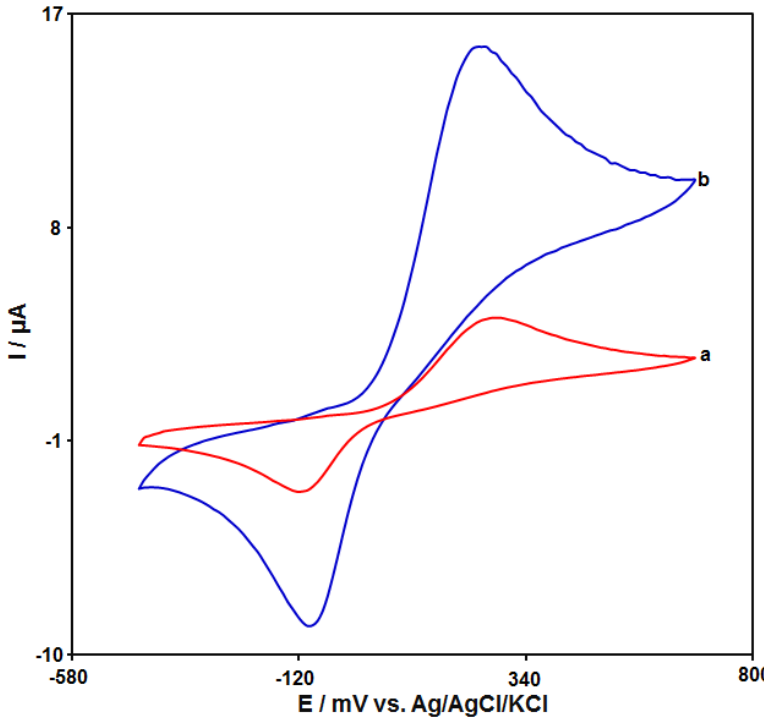
Figure 3. CVs of 50.0 µ M catechol at unmodified CPE (curve a) and GO–PAMAM/ILCPE (curve b) in the presence of 0.1 M PBS (pH 7.0) at a scan rate of 0.05 V/s.